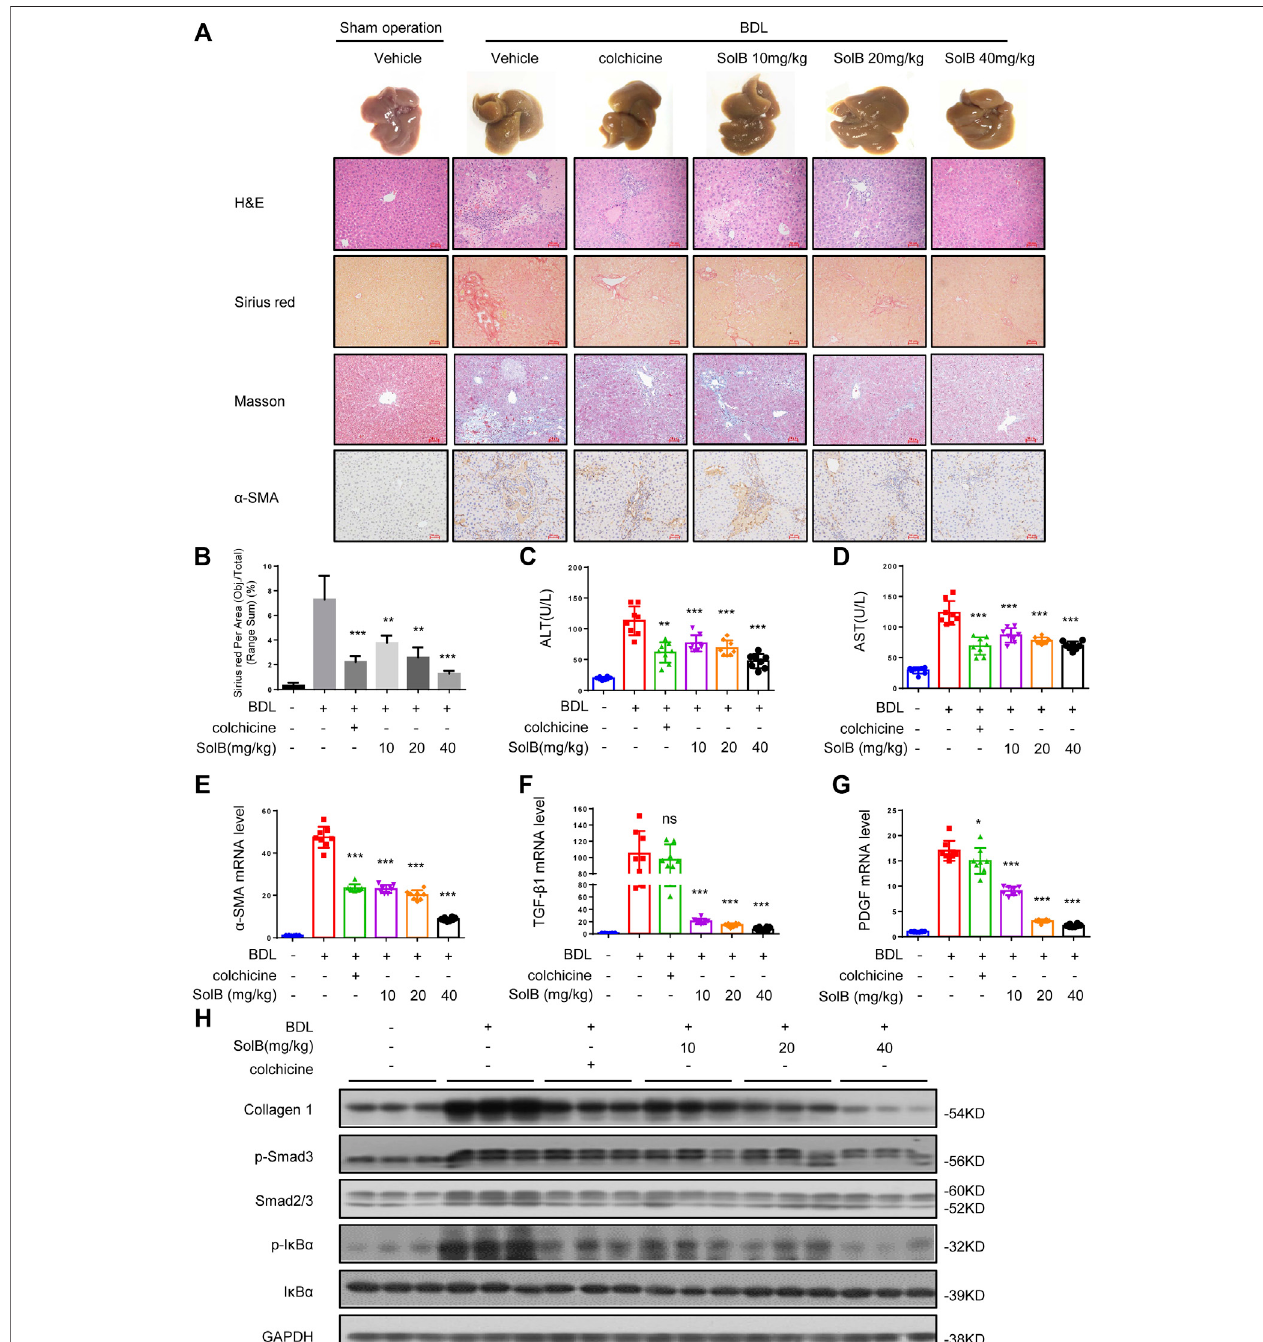
FIGURE2| SolBattenuateshepaticinjuryand fi brosisinducedbyBDLinmice (A) Imagesofliversfromsham-operatedmice(SHAM),bileduct-ligatedmice(BDL), BDL-mice treated with SolB. Representative micrographs of liver H&E staining, Sirius red, Masson staining and α -SMA were shown. Scale bars represent 50 μ m (B) Quantitative results of Sirius red staining sections (C,D) Serum level ofALT (C) and AST (D) of sham-operated mice (SHAM), bile duct-ligated mice (BDL) and BDL-mice treated with SolB or colchicine (0.2 mg/kg) (E – G) Quantitative PCR analysisof mRNA levels of α -SMA (E) , TGF- β 1 (F) , and PDGF (G) in livers from sham-operated mice,BDLmice,BDL-micetreatedwithSolB (H) WesternblotanalysisofCollagen1, p -Smad3,Smad2/3,P-I κ B α ,I κ B α ,andGAPDHinliversfromsham-operatedmice, BDL mice, BDL-mice treated with SolB. Data are expressed as Mean ± SD ( n (cid:2) 8 or 3 mice). Statistics differences were analyzed using One-way ANOVA followed by Dunnett ’ s test: * p < 0.05, ** p < 0.01, *** p < 0.001. NS, no signi fi cance.